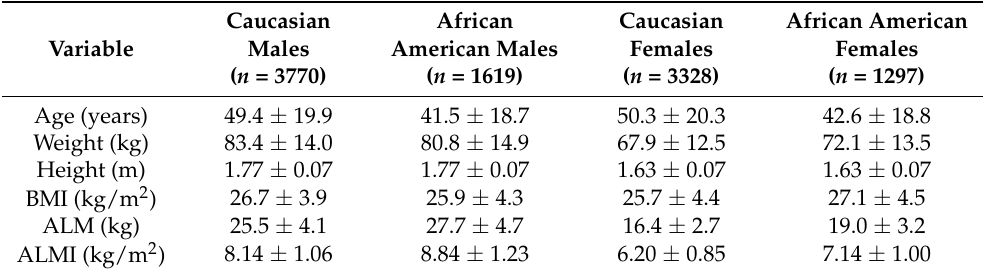
Table 1. Anthropometric variables and DXA-derived lean mass indices of the sample ( n = 10,014) according to gender and ethnicity. Data are reported as means ± standard deviations. ALM: appendicular lean mass; ALMI: appendicular lean mass index; BMI: body mass